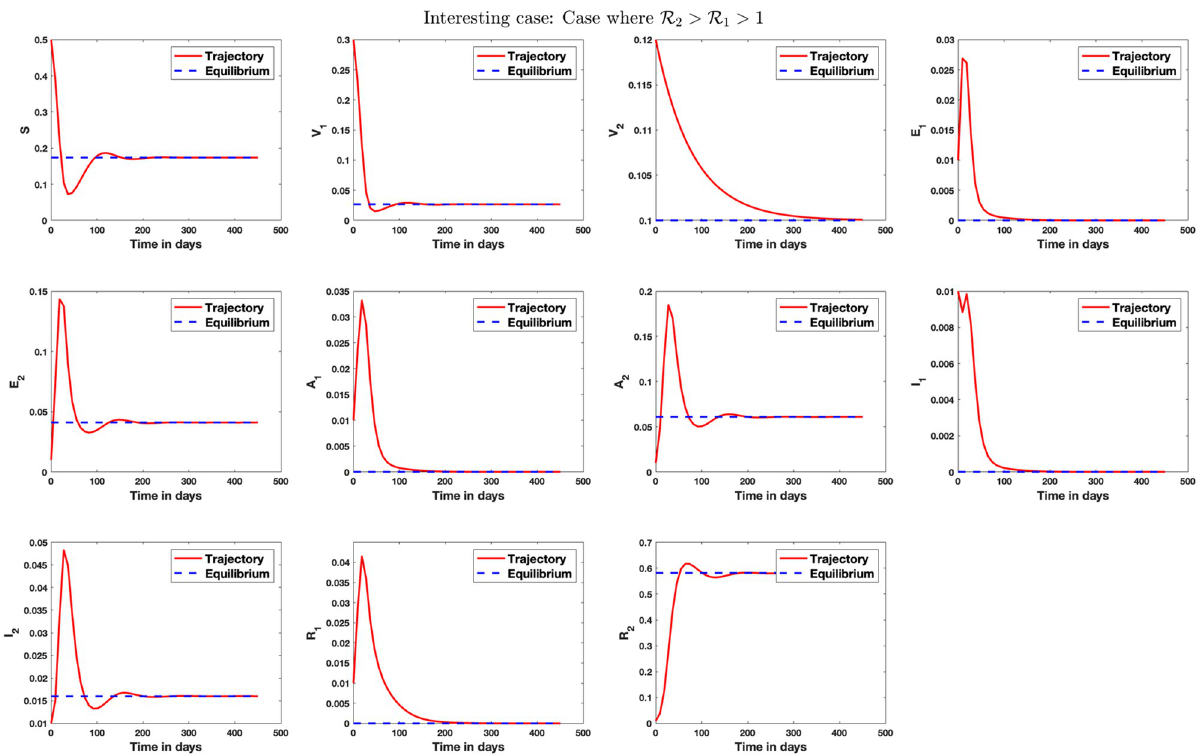
> R > 1 . In this case, we set β 1 = 0.9, β 2 = 1.0, γ 1 = 0.4, γ 2 = 0.45, μ = 1/80.3, q 1 = 0.12, q 2 = 0.1, p = 0.8, 2 1